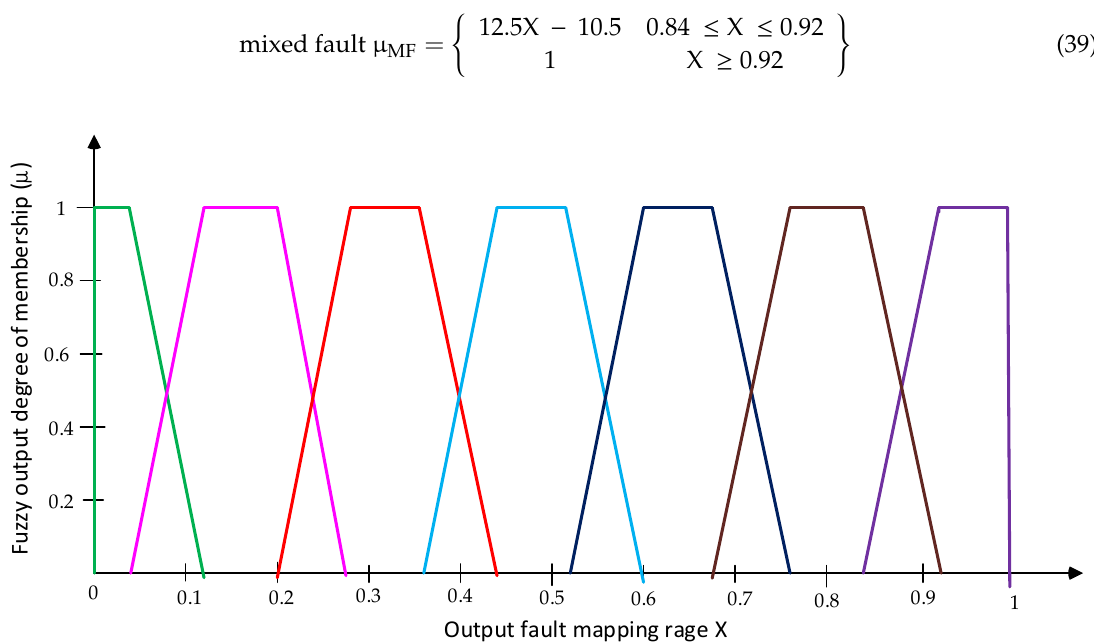
Figure 9. Functions used to defuzzify the degree of membership to crisp output.